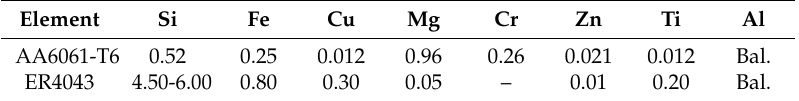
Table 1. The chemical compositions of base metal and filler wire (mass fraction, %).